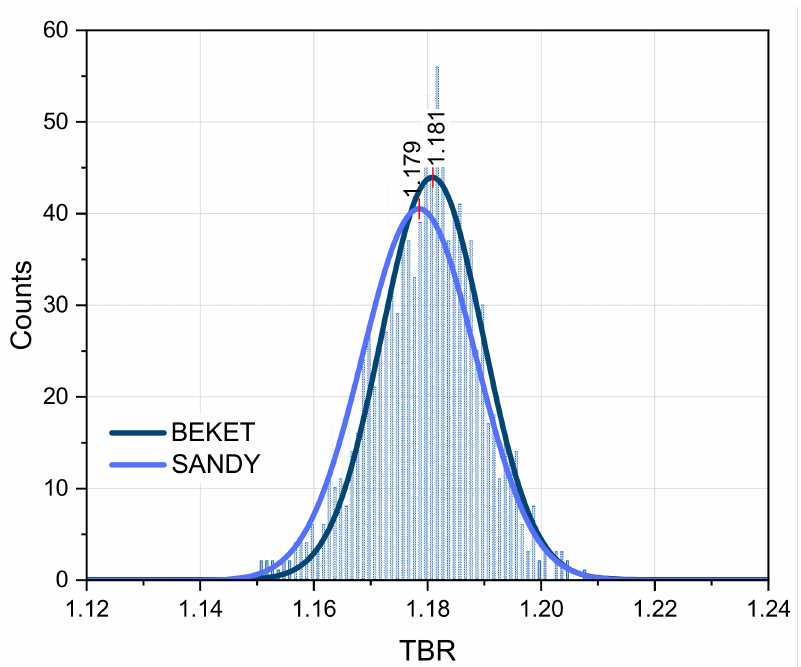
Figure 3. Distribution of the TBR with the random files obtained with BEKED and SANDY